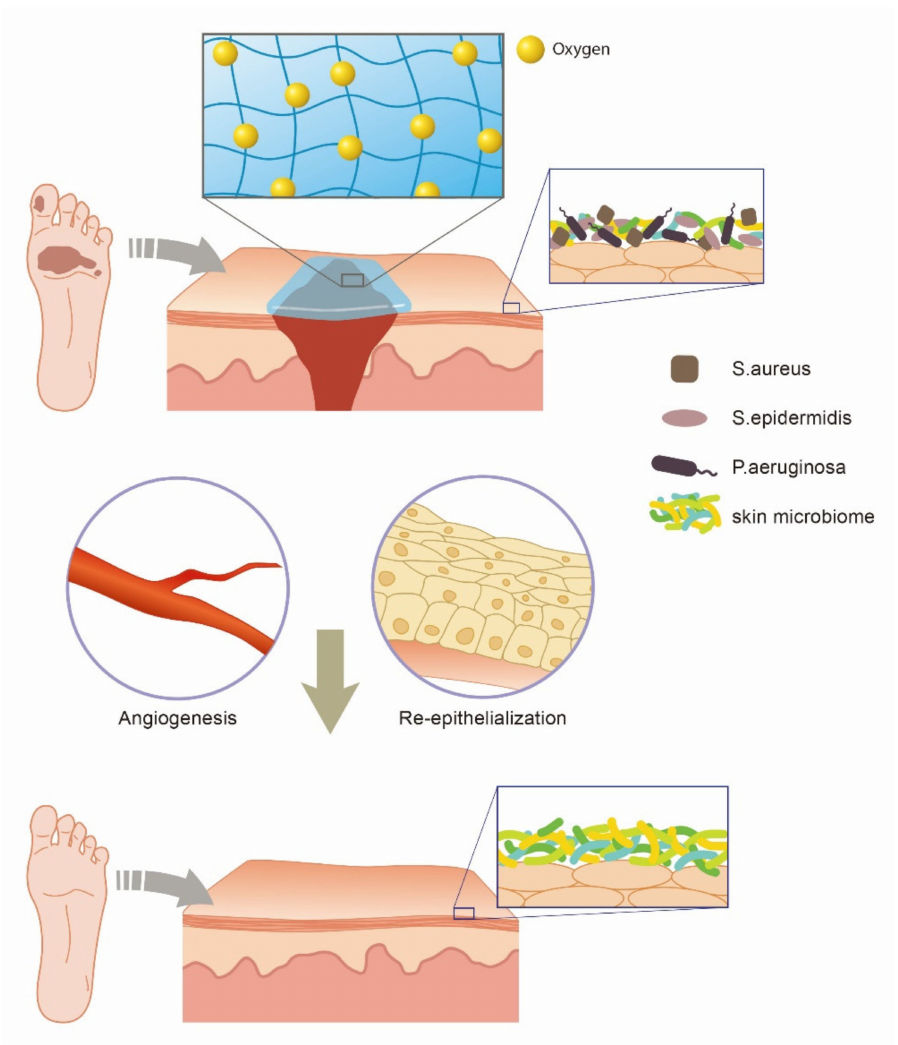
Figure 3. Role of oxygen in the management of